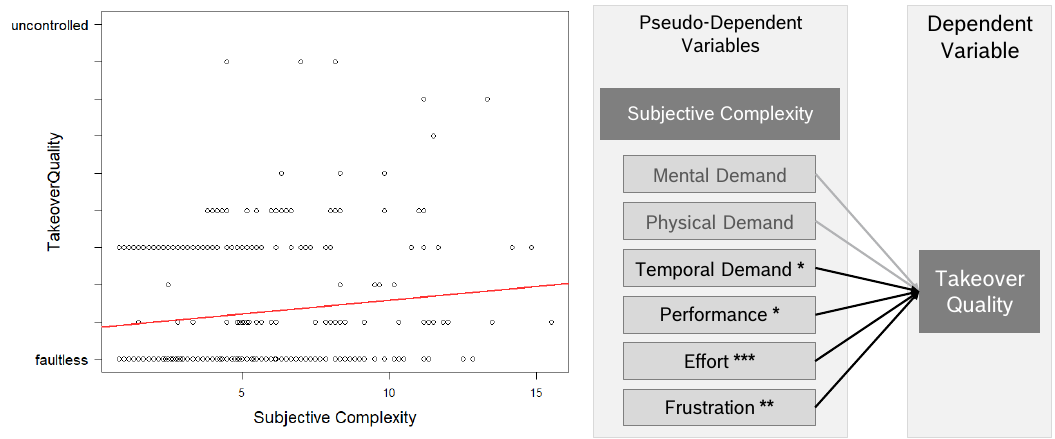
Figure 5. The relation between subjective complexity (left), its sub-scales (right) and the takeover quality. Red lines indicate the regression line (significance codes: 0 ‘***’ 0.001 ‘**’ 0.01 ‘*’